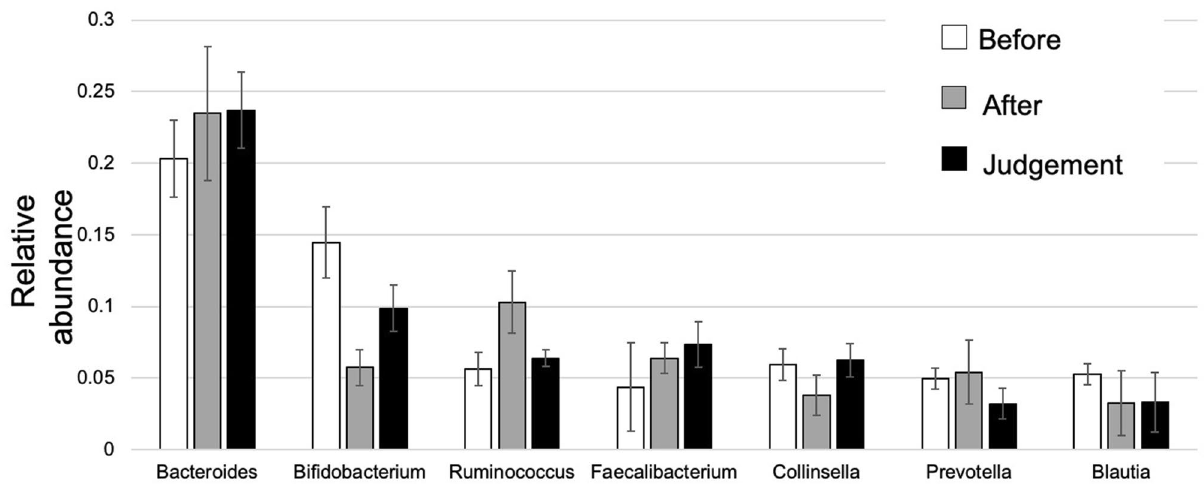
Figure 5. Relative abundance of the intestinal microbiota larger than 3% at the following three time points: before eradication therapy, after eradication therapy, and at the time of eradication therapy